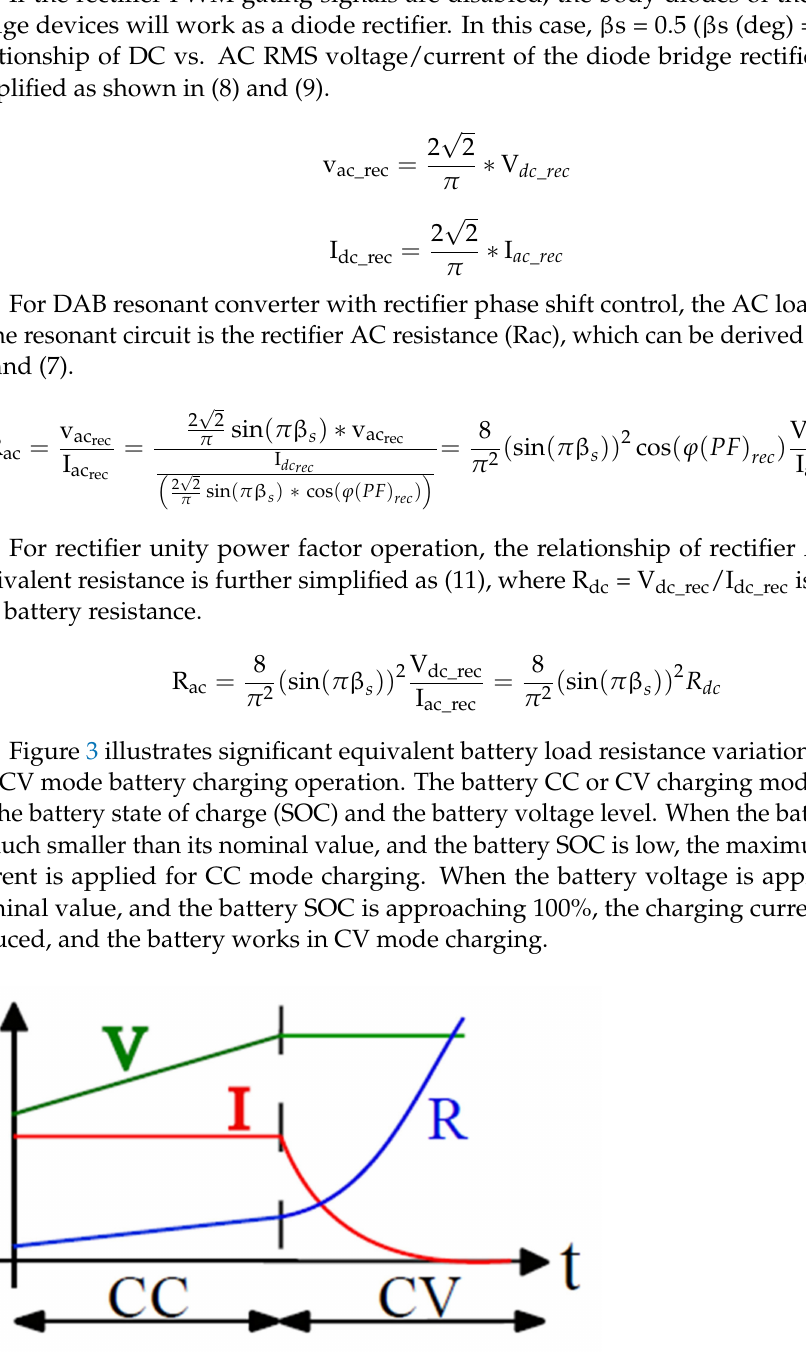
Figure 3. Battery equivalent resistance variation in CC-CV charging